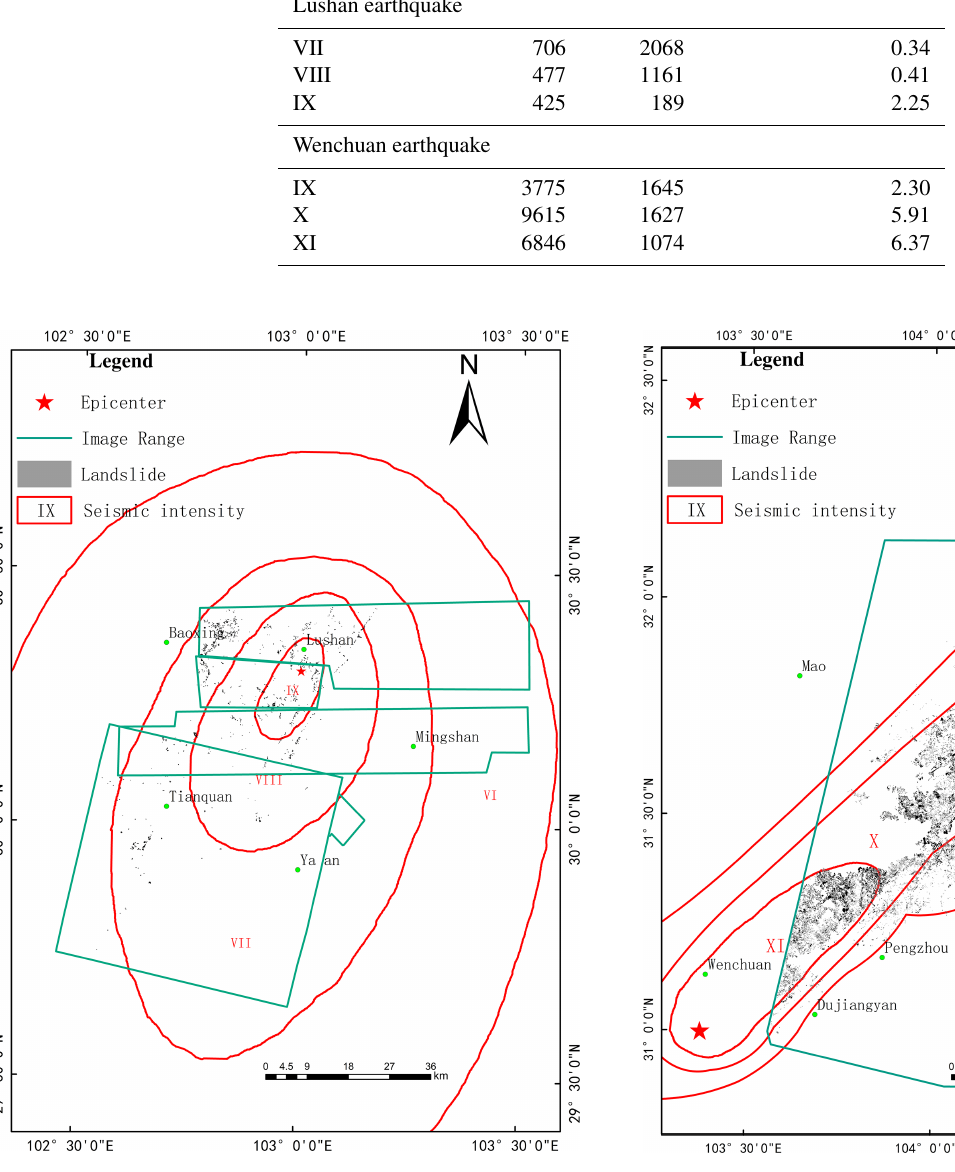
Figure 2. Distribution map of landslides triggered by the Wenchuan earthquake.